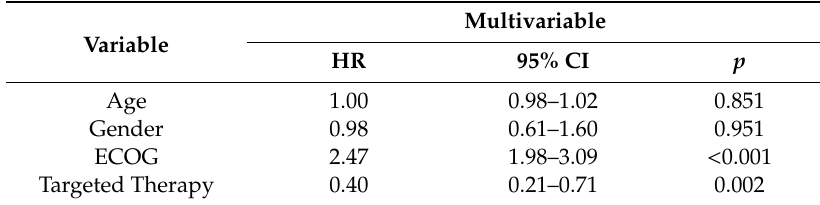
Table 3. Multivariable Cox proportional hazard model for survival, accounting for confounding variables in patients with full genotyping and diagnosed with metastatic disease through April 2019 ( n = 156). Multivariable Variable HR 95% CI p